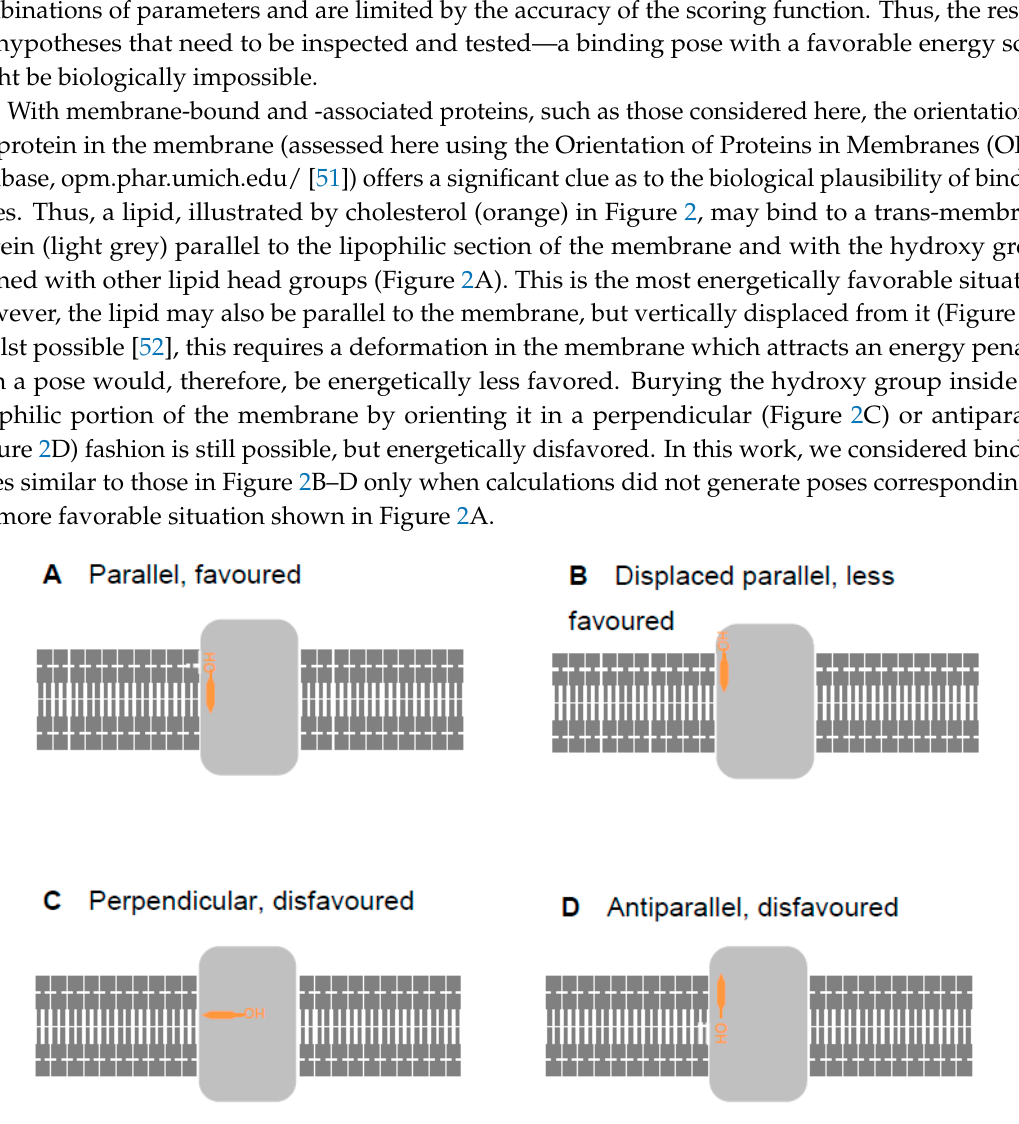
Figure 2. Four possibilities for cholesterol binding to a trans-membrane protein displayed in cartoon form. Trans-membrane proteins (light grey) are embedded in the lipid bilayer (dark grey). Cholesterol (orange) may bind parallel to the membrane ( A , energetically favored), parallel to the membrane but vertically displaced from it ( B , energetically less favored), perpendicular to the membrane ( C , energetically disfavored), or antiparallel ( D , energetically